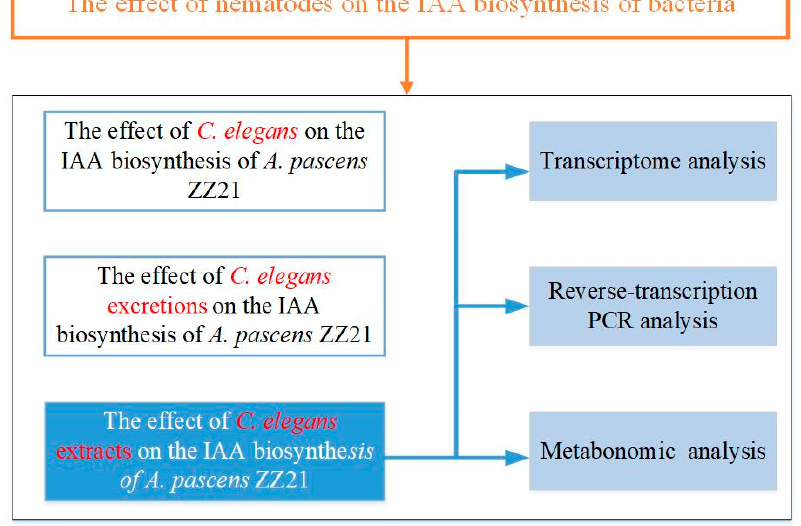
Figure 2. Flowchart of the experimental design.